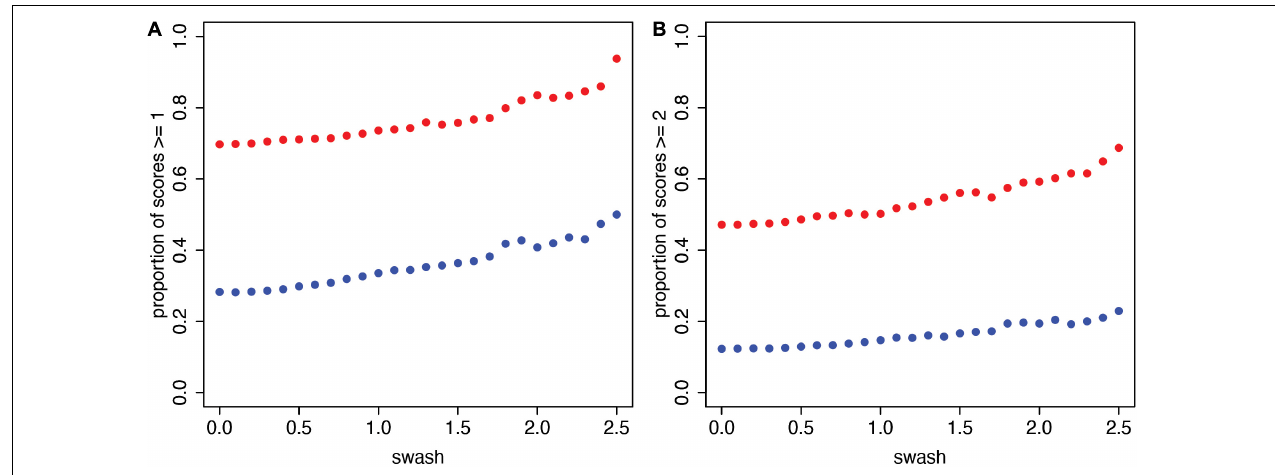
FIGURE 3 | The proportions of relatively high RHI scores ( sa , ss ) for increasing values of swash ( n = 353). (A) Proportion of scores ≥ 1. (B) Proportion of scores ≥ 2. These are the scatter plots of (cid:0) sw , prop sa ≥ s ( sw ) (cid:1) (asynchronous, blue) and (cid:0) sw , prop ss ≥ s ( sw ) (cid:1) (synchronous, red) for sw = 0 to 2.5 in steps of 0.1 and for each of s = 1 (A) and s = 2 (B) . It can be seen that there is a stable relationship, with higher proportions of participants reporting a stronger RHI in the synchronous condition ( ss ) compared to the asynchronous condition ( sa ) across the range of trait hypnotisability scores ( swash ) possible with these data.